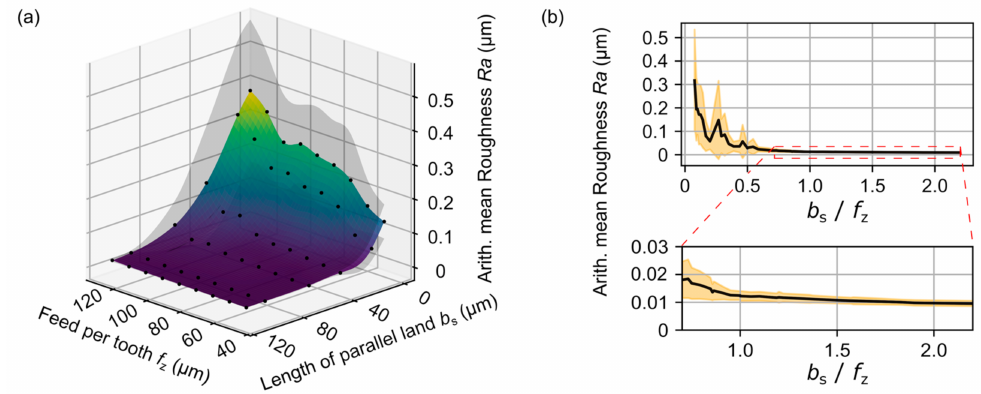
Figure 6. ( a ) depicts the arithmetic mean roughness, Ra , of the surfaces, generated with the MRS using different tool models with various wiper lengths and the reference tool. The factor b s / f z and the corresponding Ra are shown in ( b